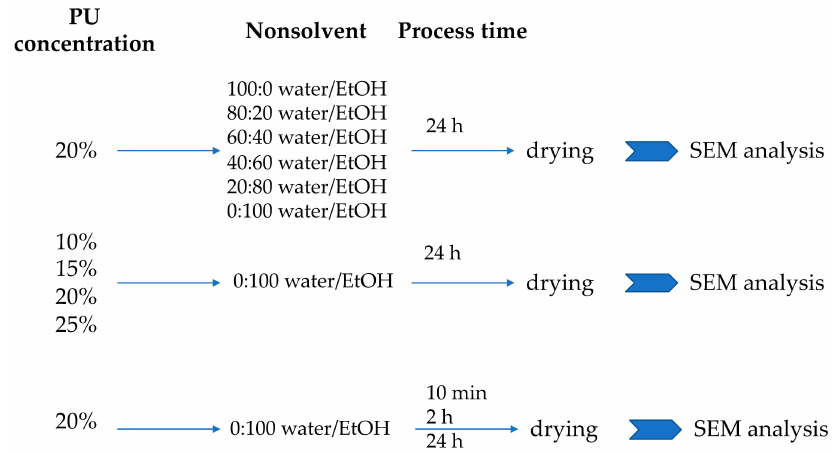
Figure 12. The scheme of testing selected process parameters.